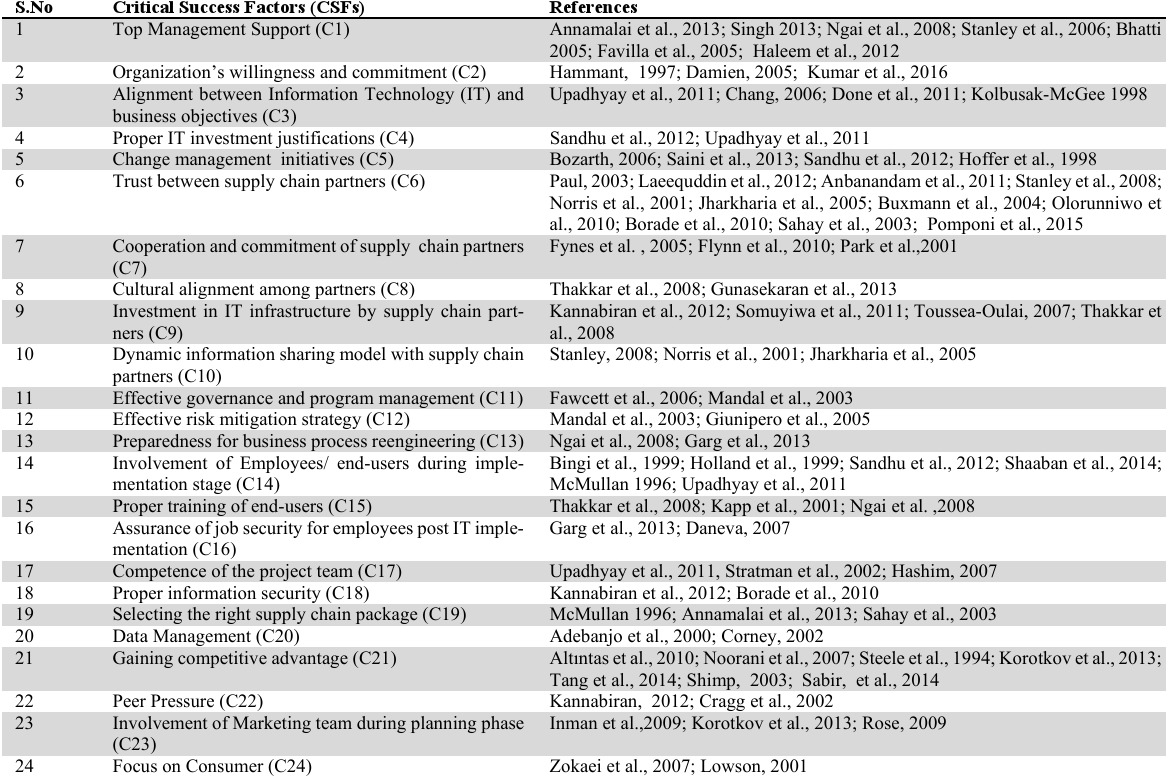
Critical Success Factors